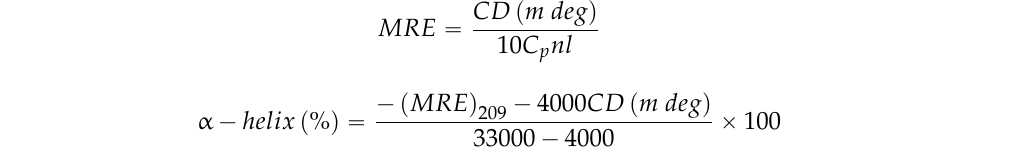
Figure 4. Synchronous fluorescence spectra of the SSC-HSA system. The experimental conditions were as described in Figure 2. A, Δλ = 15 nm for tyrosine; B, Δλ = 60 nm for tryptophan. C HSA = 2 μ M.